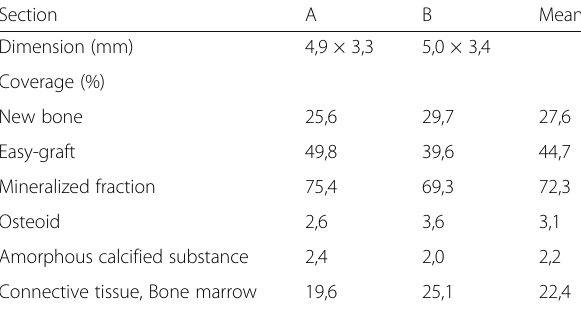
Table 2 Histomorphometric Assessment of Bone Cores from 1